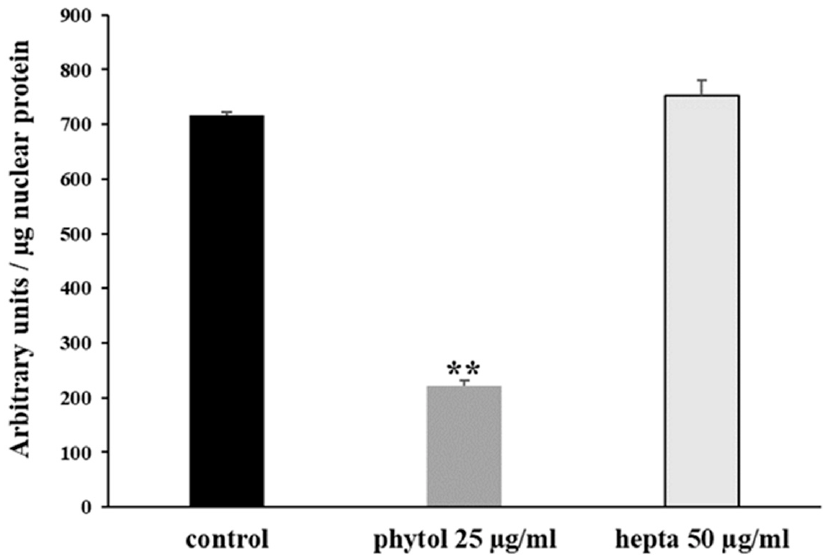
Figure 1. NF- κ B (p65 subunit) DNA binding capacity in nuclear extracts of HL-60R cells. The cells were treated for 24 h with phytol and heptacosane (hepta) at the indicated concentrations. Results (mean ± standard error of three experiments carried out in duplicate) are expressed as arbitrary units/ µ g protein of cells nuclear extracts. Statistical differences are ** p < 0.01, vs. the control (one-way ANOVA followed by Tukey’s test).